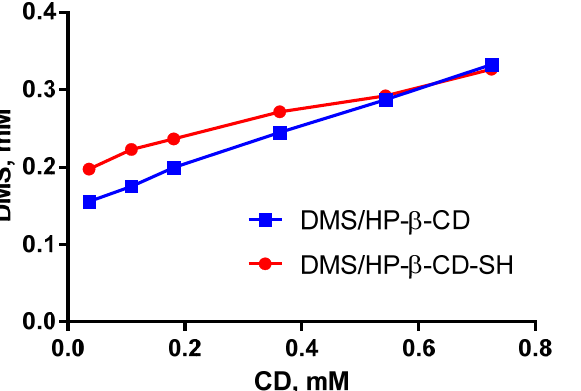
Figure 4. DMS solubility profiles in the presence of HP- β -CD or HP- β -CD-SH. Each point is the mean ± SD of 3 values.